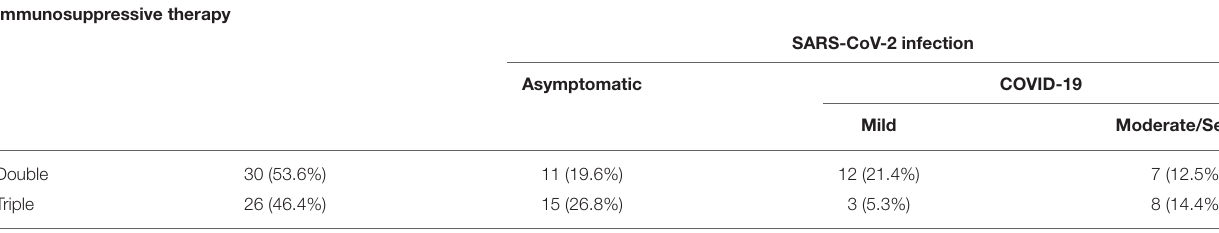
TABLE 4 | Single vs. dual vs. triple immunosuppressive therapy in patients with SARS-CoV-2 infection. Immunosuppressive therapy